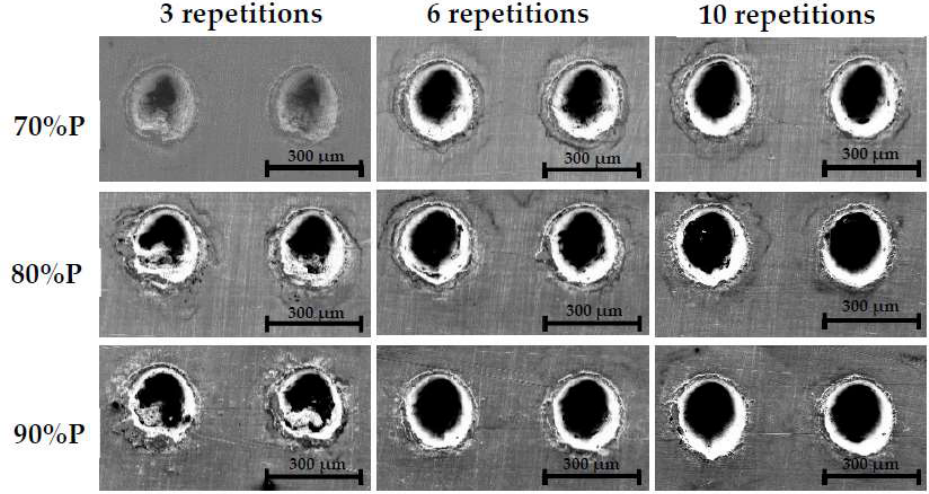
Figure 3. SEM images of the dimples obtained on the textured surface of the ASTM F-1537 cobalt alloy employing a repetition rate of 140 kHz.